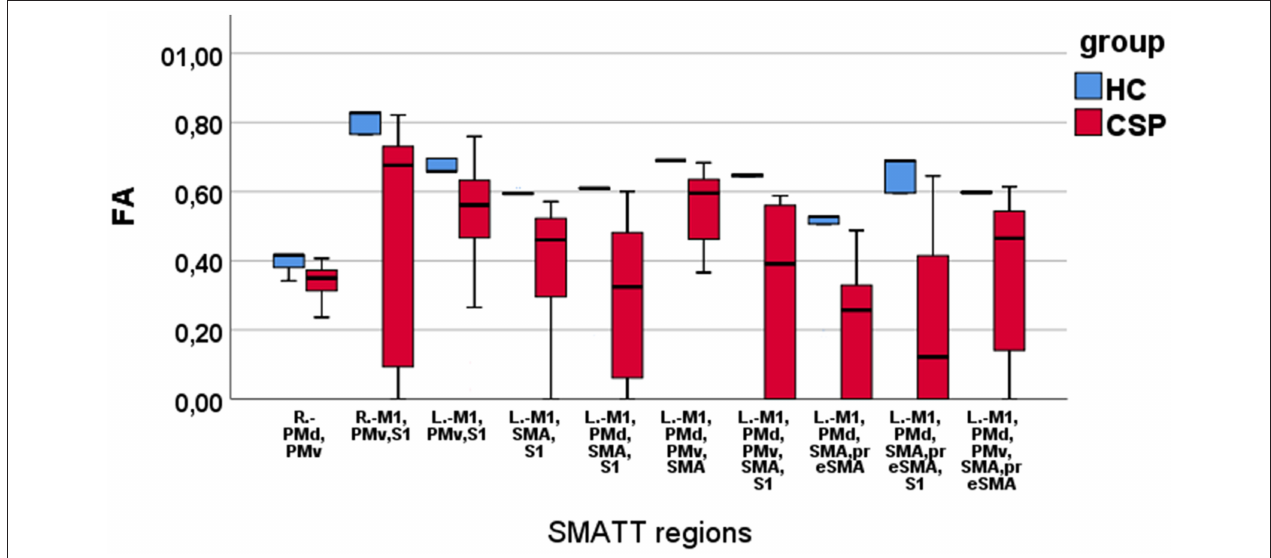
FIGURE 3 | Boxplots of FA values in SMATT regions with significant differences between HC and CSP group. Note that the HCs have higher and less scattered FA values compared with the CSPs.